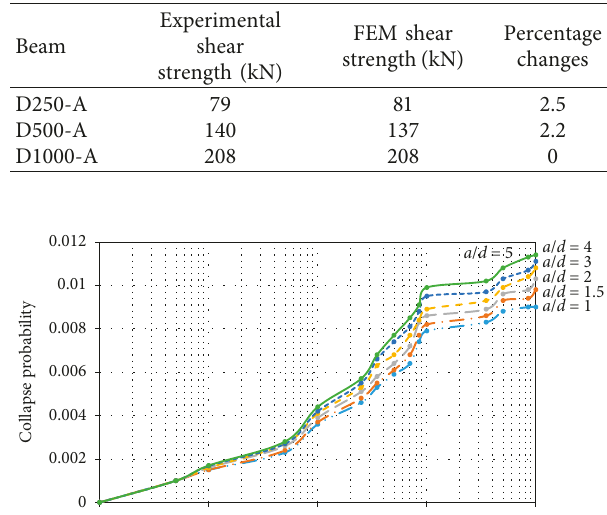
40% of the beam (cid:29)